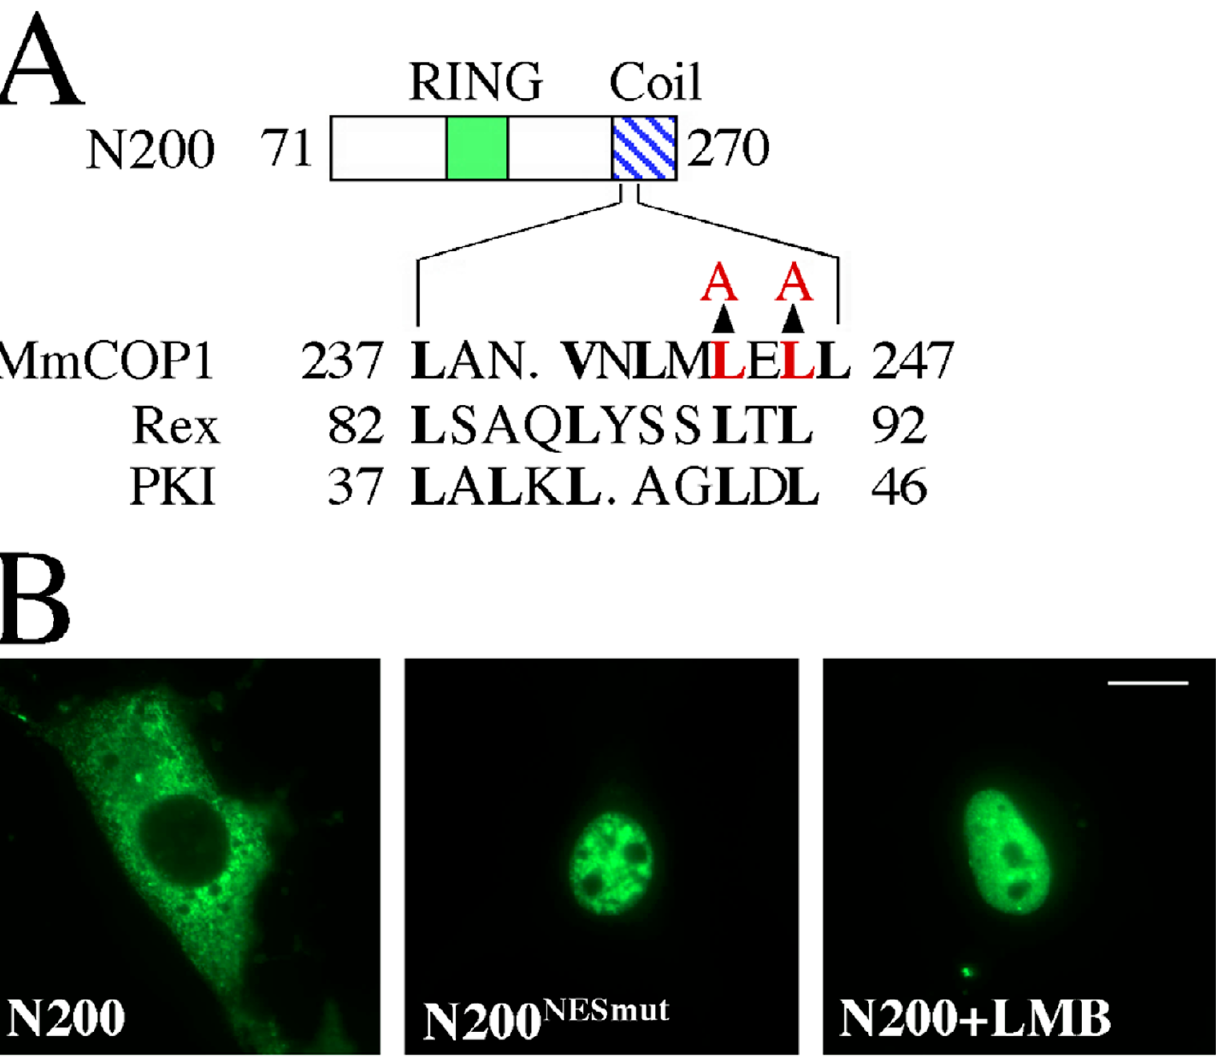
Figure 6 Mapping the nuclear export signal of mammalian COP1 protein (A) Diagram of the amino acid sequence of the wild- type COP1 NES, the alignment with the NESs of Rex and PKI. The amino acid replacements in the mutant protein (N200 NESmut ) are indicated by arrows. The conserved key residues are shown in boldface. Residues altered by site-directed mutagenesis are highlighted in red. (B) GFP fluorescence study of the subcellular localizations of GFP-N200 and GFP- N200 NESmut . The studies were carried out in COS7 cells. When indicated, cells were cultured in the presence of 10 ng/ml LMB for 3 hrs before fixation. LMB, leptomycin B. The same magnification was used for all images and the scale bar for 10 microm- eter was indicated in the N200+LMB